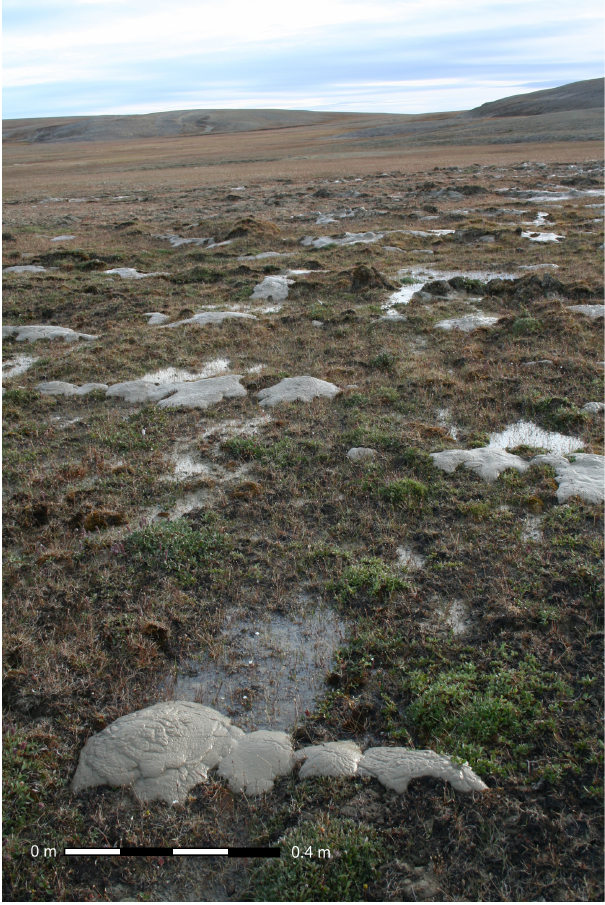
Figure 6. MEs adjacent to an ALD at CBAWO on 28 July 2007. The photo was taken at the edge of the ALD looking out towards the MEs and the adjacent